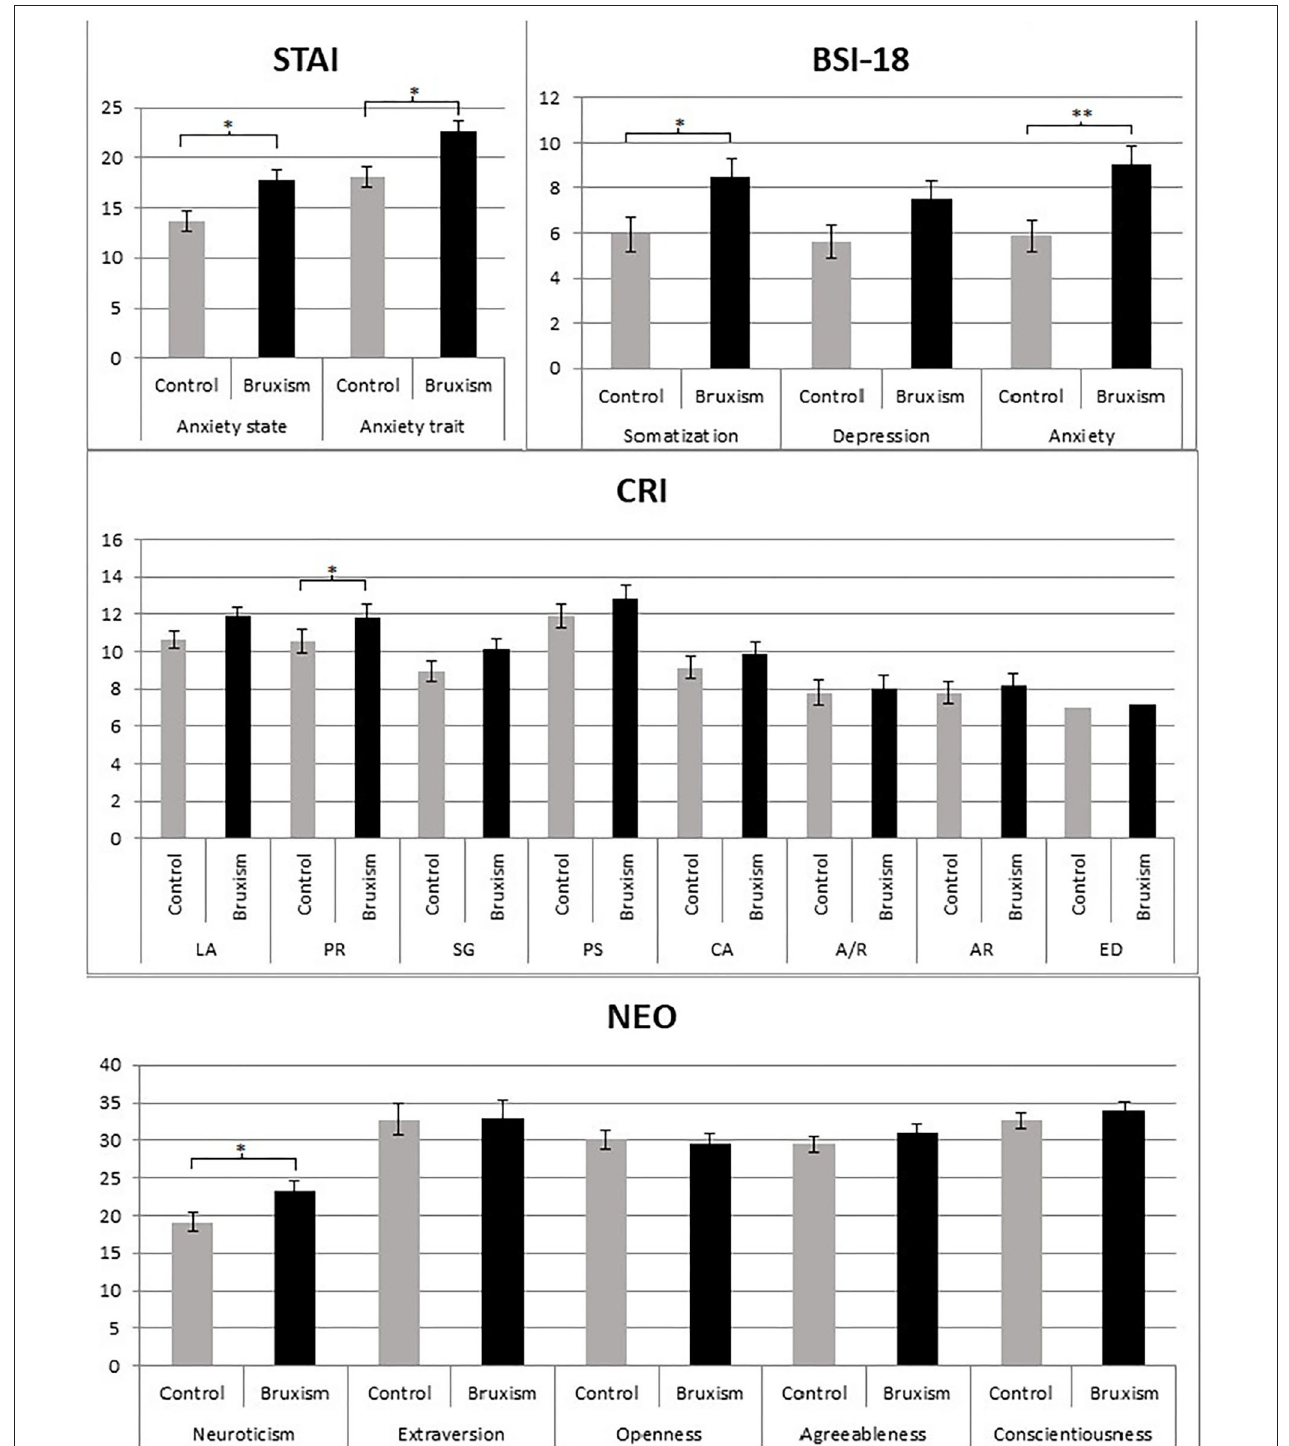
FIGURE 1 | Averages and standard errors of STAI (State and Trait Anxiety Inventory); BSI-18 (Brief Symptom Inventory), CRI-A (Coping Responses Inventory—Adult form), and NEO-FFI (NEO Personality Inventory) scales for control and bruxers groups. Graphics for ST-DEP (State and Trait Depression Inventory) are not included due to the lack of significant results, however, means and statistical analyses can be seen in Table 1 . LA, logical análisis; PR, positive reappraisal; SG, seeking guidance and support; PS, problem solving; AV, cognitive avoidance; A/R, acceptance and resignation; AR, seeking alternative rewards; ED, emotional discharge. * p < 0.05; ** p < 0.001. Bars represent the standard error of the mean.